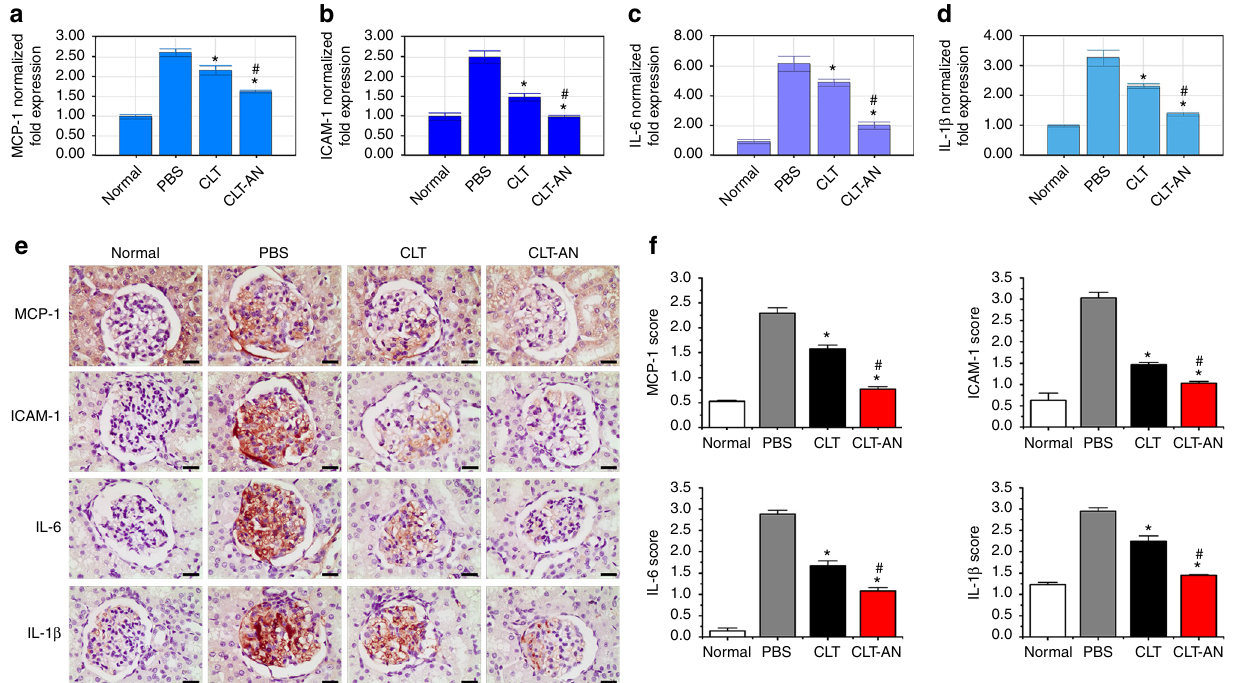
Fig. 6 Anti-in fl ammatory effects of CLT and CLT-AN in anti-Thy1.1 nephritic rats. a – d Real-time PCR analysis of renal mRNA levels of MCP-1 ( a ), ICAM-1 ( b ), IL-6 ( c ), IL-1 β ( d ) in anti-Thy1.1 nephritic rats on day 1 after treatment with CLT or CLT-AN. Data are shown as normalized fold expressions relative to normal group using β -actin mRNA as internal control. e Representative photomicrographs of immunostaining for MCP-1, ICAM-1, IL-6, and IL-1 β in kidney tissue sections taken from anti-Thy1.1 nephritic rats on day 1 after treatment with CLT or CLT-AN. Scale bars , 20 μ m. f The levels of MCP-1, ICAM-1, IL-6, and IL-1 β were semiquantitatively scored as described in Methods on the basis of immunohistochemical results. In panels a – d and f data are mean ± s.d. ( n = 5), results are representative of two independent experiments. * P < 0.05 vs. PBS group; # P < 0.05 vs. CLT group. Statistical signi fi cance was determined by one-way ANOVA with Tukey post hoc